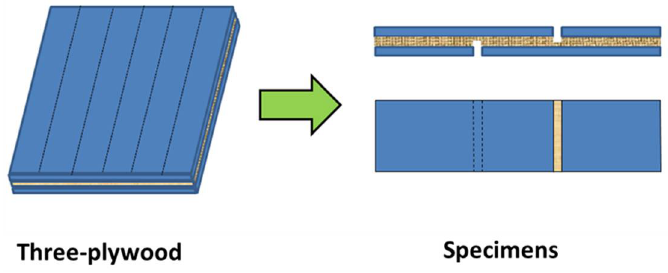
Figure 1. Preparation of the specimens for shear strength testing.